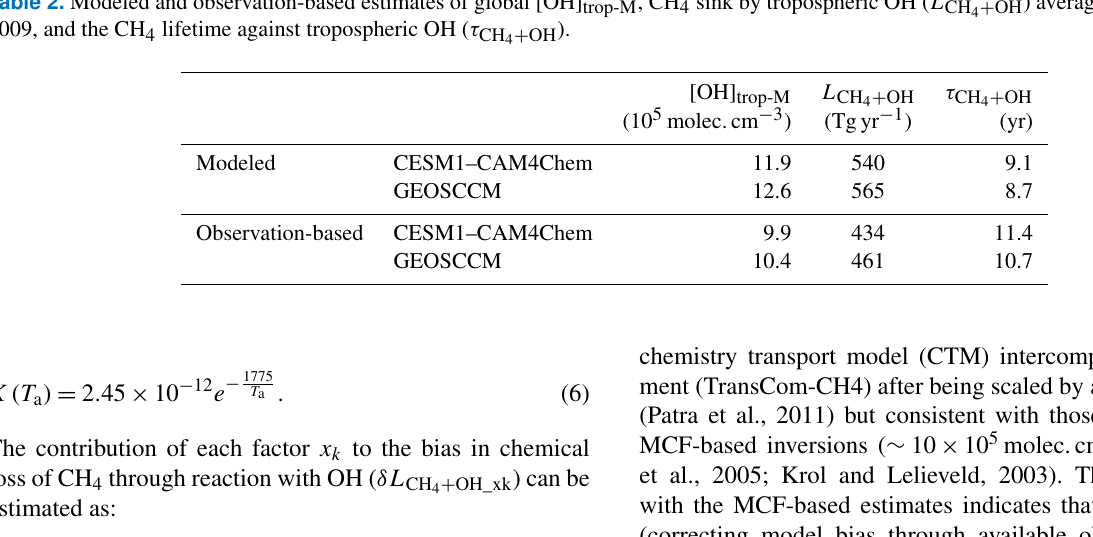
) averaged during 2000– 4 + OH